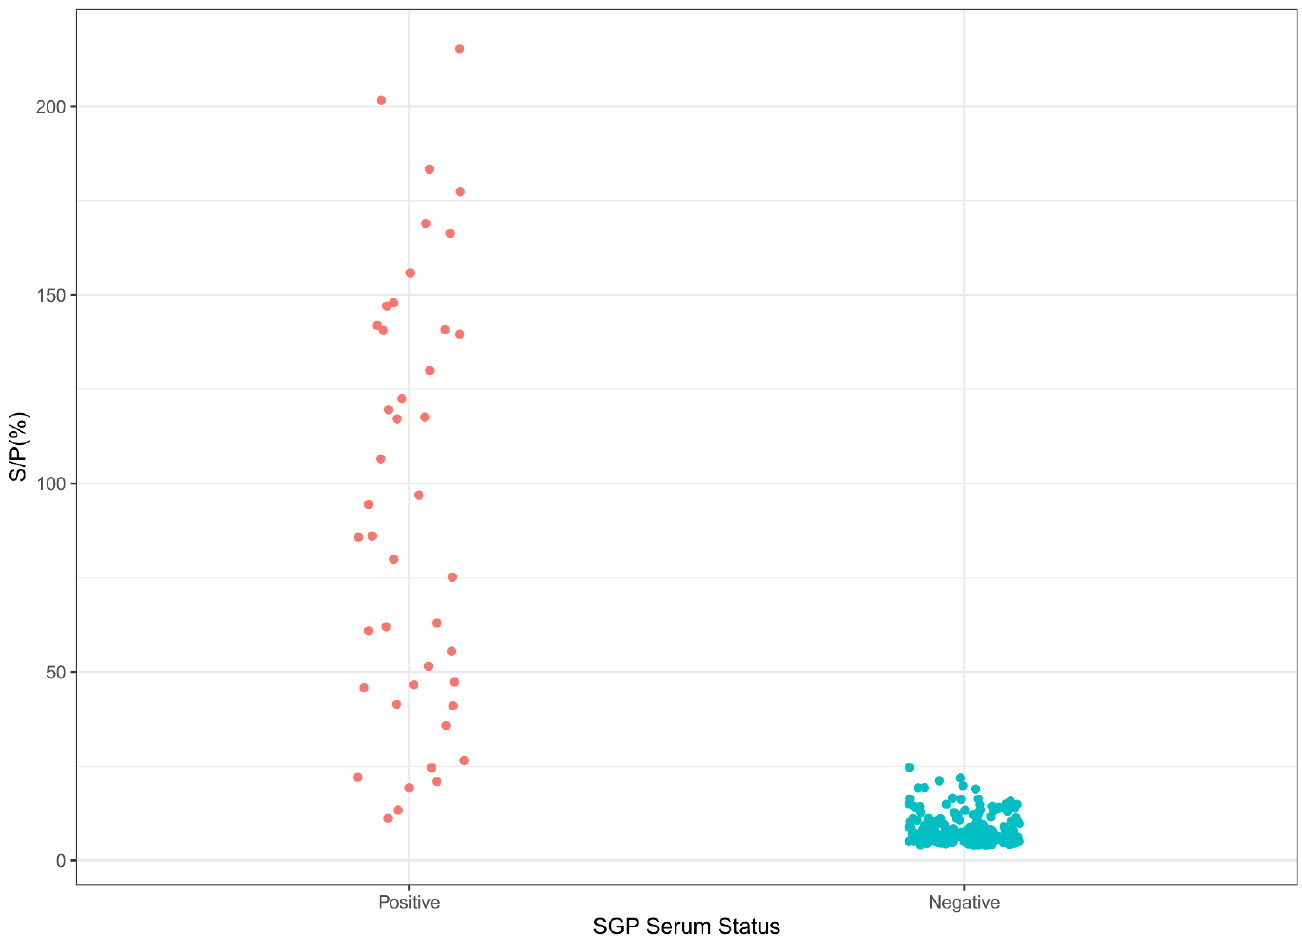
Figure 3. Sample distribution of the SGP iELISA. SPP- or GTP-positive (46) and -negative (216) serum samples were tested, using conditions for SPP/GTP iELISA.